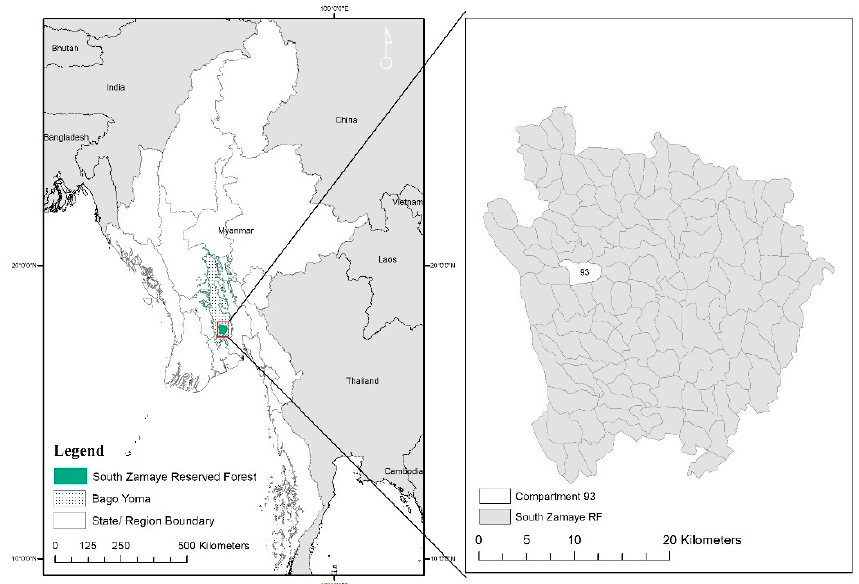
Figure 1. Location of the study site in Compartment 93, South Zamaye Reserved Forest, Bago Yoma, Myanmar.